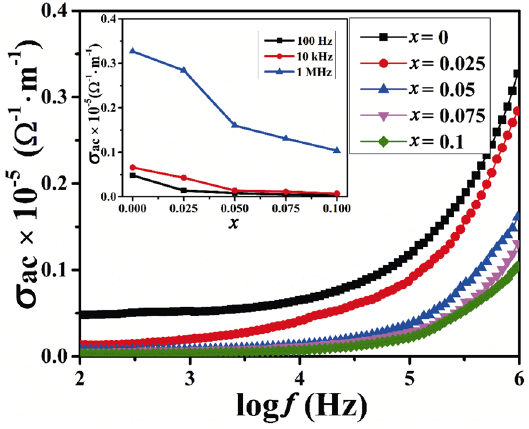
Fig. 10 Variation of AC conductivity of Mn 0.5 Zn 0.5 Gd x Fe 2– x O 4 ( x = 0, 0.025, 0.050, 0.075, and 0.10) with